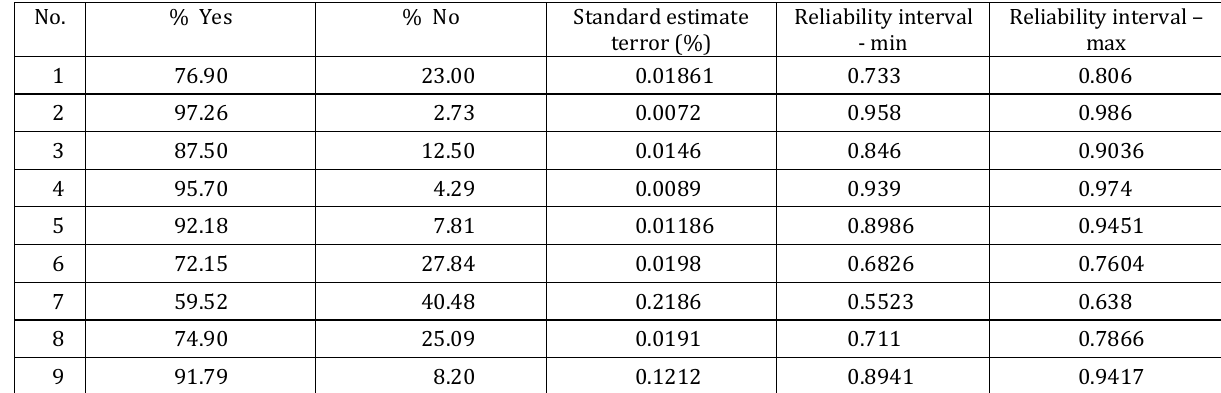
Table 2. Results of dichotomous